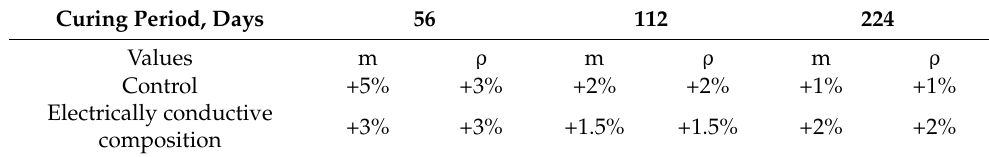
Table 3. Change in the mass and density of the samples during the test from the initial